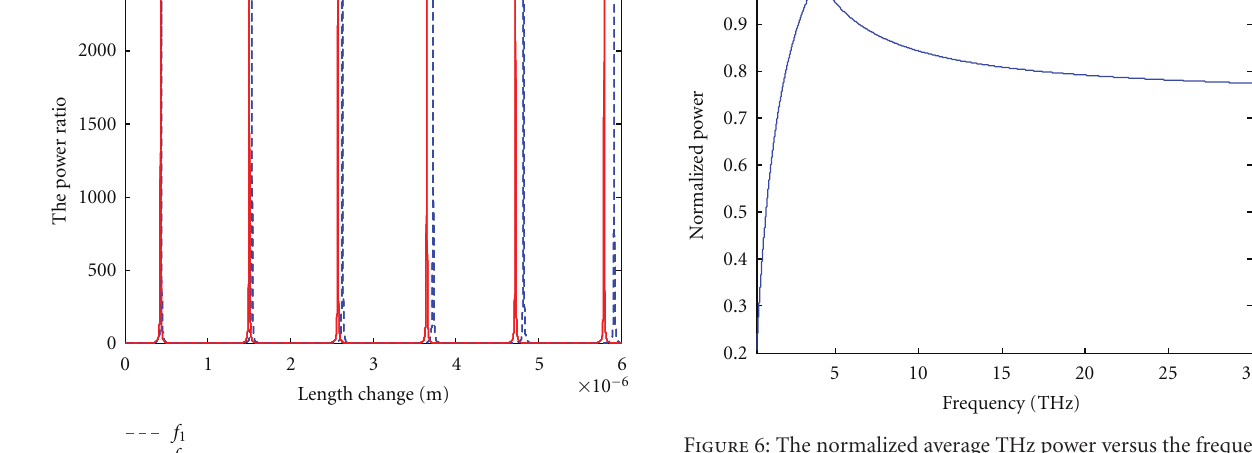
Figure 6: The normalized average THz power versus the frequency of the generated THz